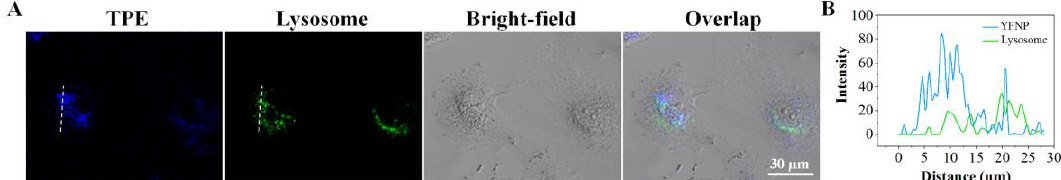
Figure 7 . The confocal fluorescence images of MCF-7 cells pretreated with or without curcumin (control), respectively, followed by further incubation with the YFNP (MCF-7 cells were pretreated with curcumin for 24 h).